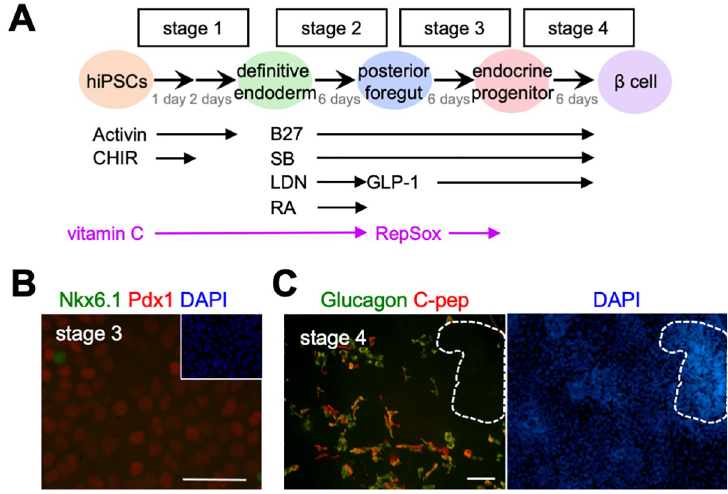
Fig 1. Analysis of differentiation state of iPSCs induced by a simplified induction method into pancreatic β -cells. ( A ) Summary of the protocol. Activin, Activin A; CHIR, CHIR99021; SB, SB431542; LDN, LDN193189; RA, retinoic acid; GLP-1, Glucagon-like peptide-1; RepSox, ALK5 inhibitor. ( B ) Immunohistochemistry at stage 3. The expression of Nkx6.1 (green), Pdx1 (red). DAPI staining shown in blue. Scale bar: 100 μ m. ( C ) Immunohistochemistry at stage 4. The expression of glucagon (green) and C-peptide (red). DAPI staining shown in blue. Circles with a dashed line indicate the mass region. Scale bar: 100 μ m.